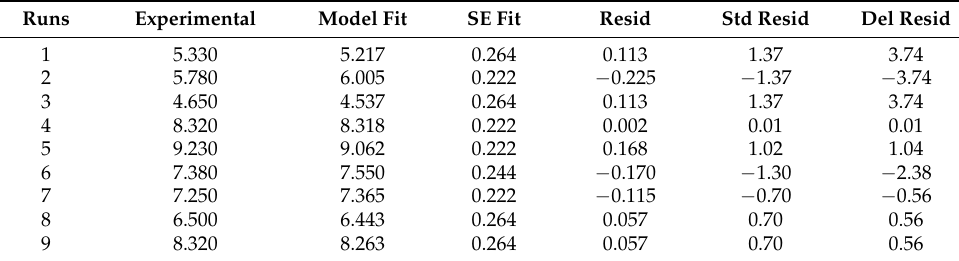
Table 9. Fits and diagnostics for all observations for energy absorption capacity.